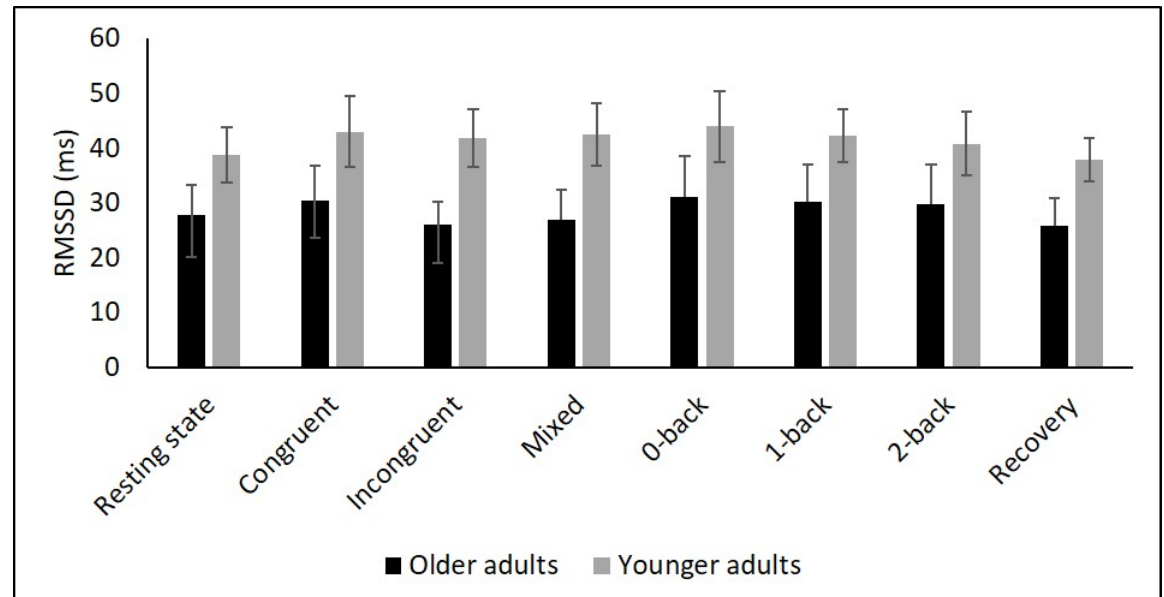
Figure 4. Means for RMSSD. Error bars indicate ±2 standard error of mean; abbreviations: ms: milliseconds; RMSSD: root mean square of successive NN interval differences.